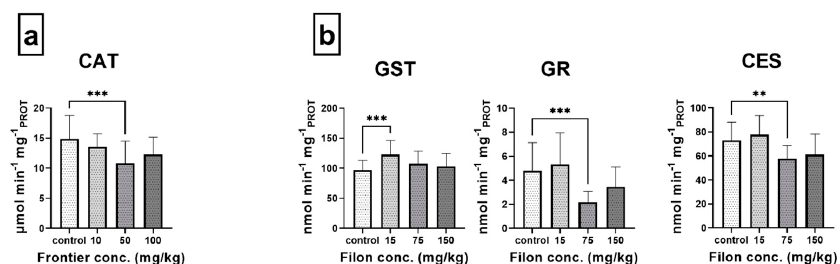
Figure 2. Biomarker responses after 48-h exposures to herbicides Frontier and Filon in soil. Carboxylesterase (CES), glutathione S-transferase (GST), glutathione reductase (GR), and catalase (CAT) activities measured in E. andrei earthworms exposed to the commercial pesticide preparations ( a ) Fron- tier (active ingredient dimethenamid-p) and ( b ) Filon (active ingredient prosulfocarb) for 48 h in LUFA 2.2 soil. Results are presented as mean ± standard deviation ( n = 20) and only significant differences (** p < 0.01 and *** p < 0.001) between control and pesticide treatments are shown (ANOVA followed by Dunnett’s multiple comparison test).